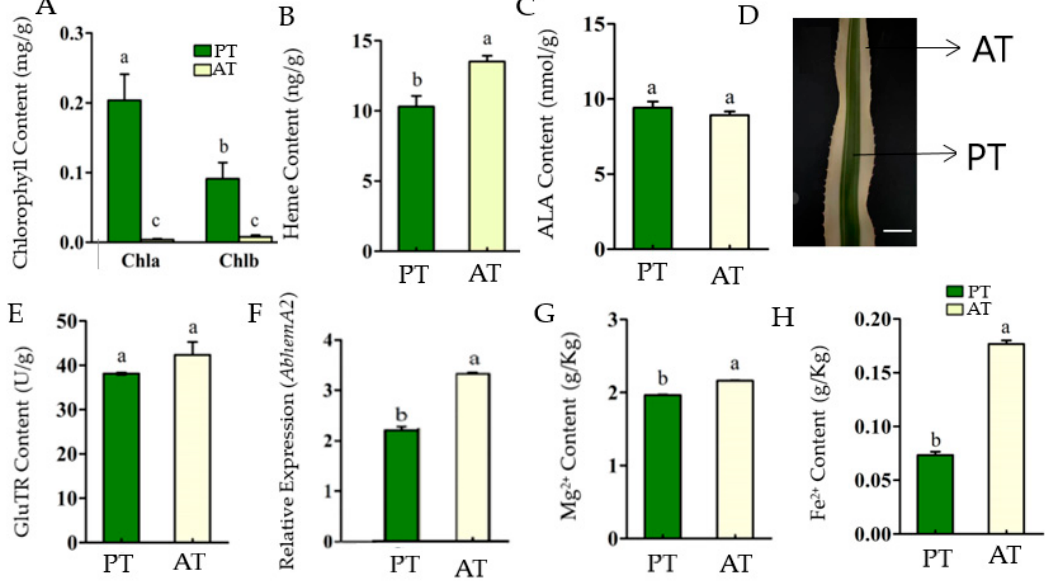
Figure 1. The porphyrin metabolism characterizes in the central photosynthetic tissue (PT) and marginal albino tissue (AT) of the chimeric leaves of Ananas comosus var. bracteatus . Chlorophyll content ( A ), heme content ( B ), 5-aminolevulinic acid content ( C ), Chimeric leaf (Photosynthesis tissue (PT) and marginal Albino tissue (AT) at 100 µm scale bar ( D ), GluTR content ( E ), Relative expression of AbHemA2 ( F ), Mg 2+ content ( G ), and Fe 2+ content ( H ). The bars show how each bar differs from the others. The means denoted by the same letter did not differ significantly at p < 0.05.